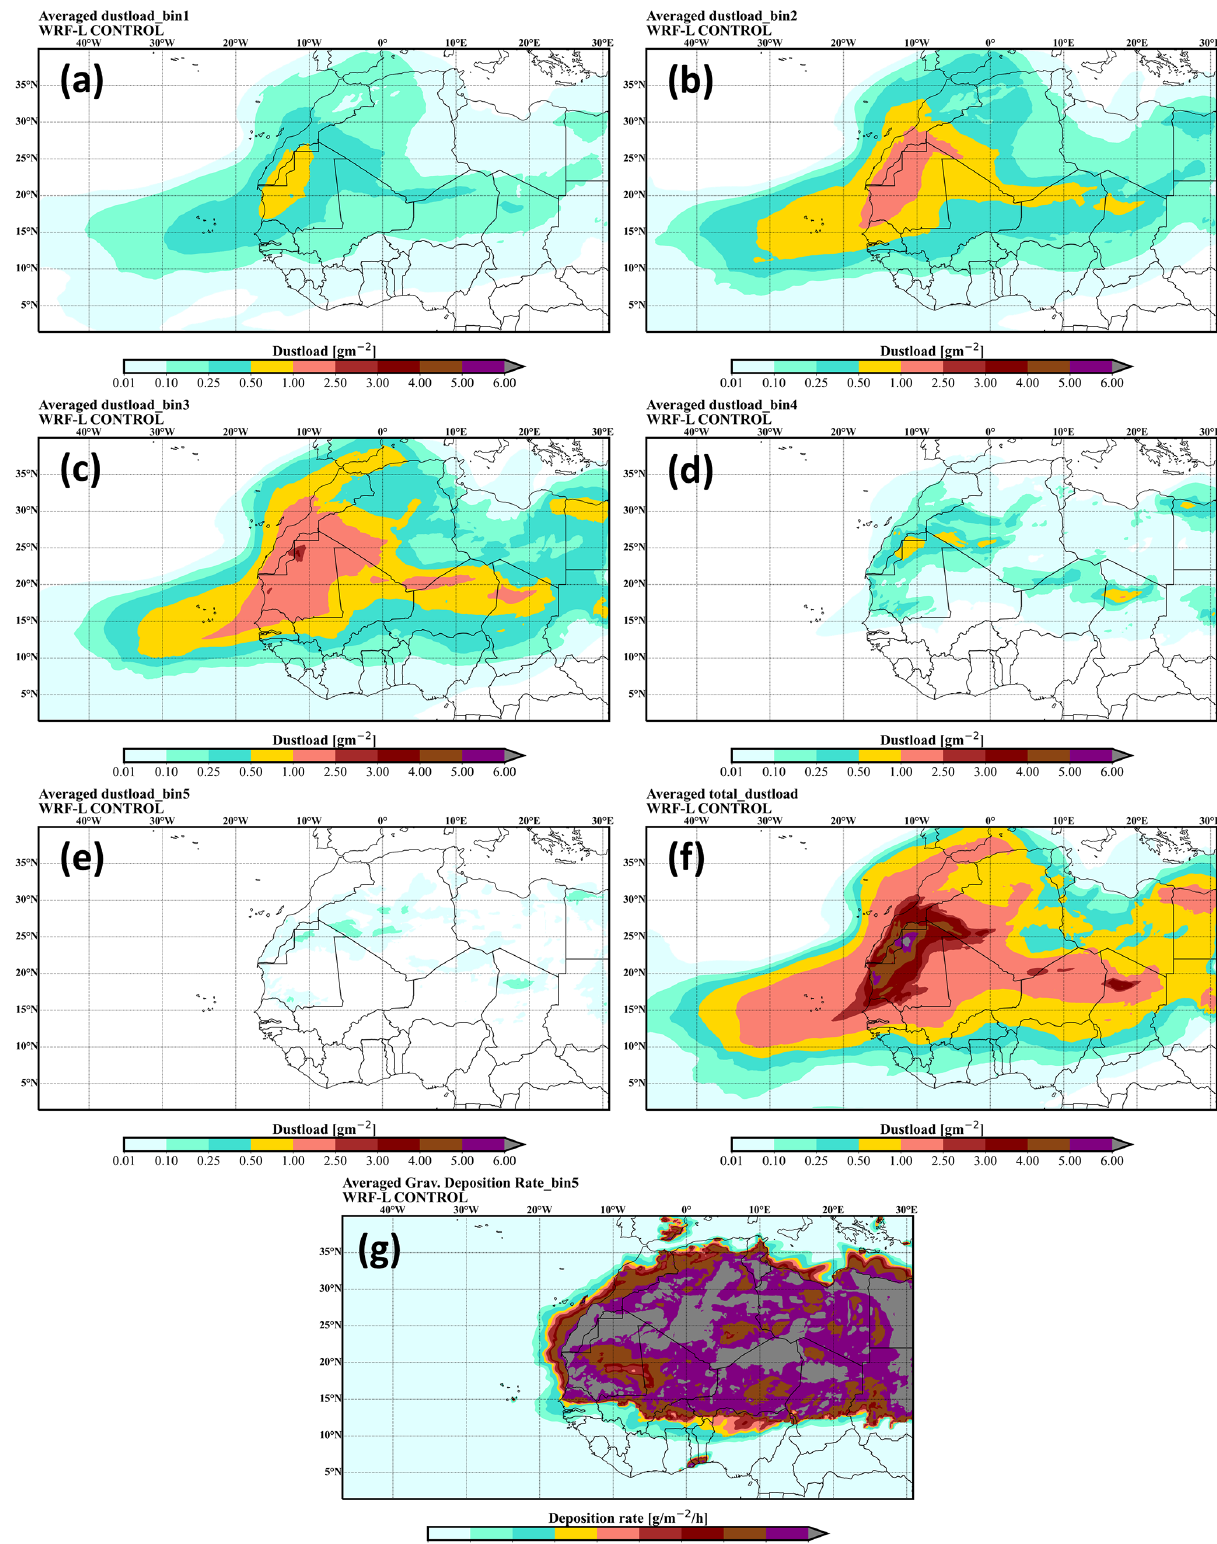
Figure 6. The dust load provided by the model, averaged for the whole simulation period, for (a) bin 1, (b) bin 2, (c) bin 3, (d) bin 4, (e) bin 5, and (f) the whole range of the PSD. The dust load is in gm − 2 . (g) The gravitational deposition rate for bin 5 in gm − 2 h − 1